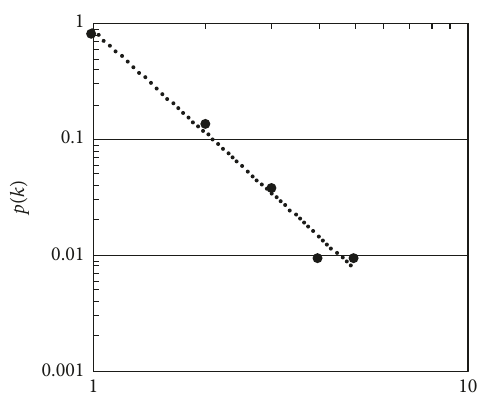
Figure 7: The distribution of terms in the logarithmic graph (the vertical axis represents occurrence probability, and the horizontal axis represents the frequency of terms).